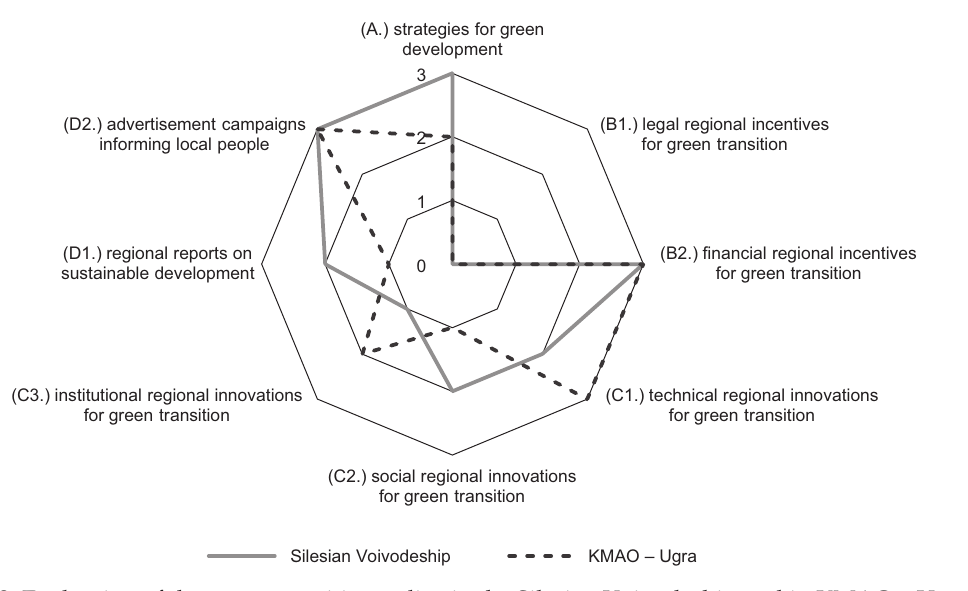
Fig. 2. evaluation of the green transition policy in the Silesian Voivodeship and in KMAO – Ugra. KMAO – the Khanty-Mansiysk Autonomous Okrug. Source: own